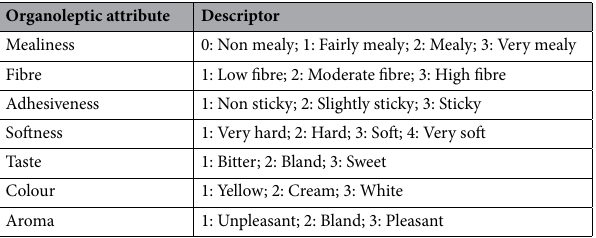
Table 4. Scales used in sensory analysis of boiled cassava roots. Hedonic scale: Mealiness, 0–3; Fibre, 1–3; Adhesiveness, 1–3; Softness, 1–4; Taste, 1–3; Colour, 1–3; Aroma,